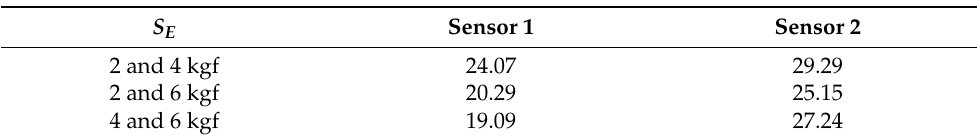
Table 9. Result of sensor data efficiency evaluation for optimal sensor selection of printing roll eccentricity fault.